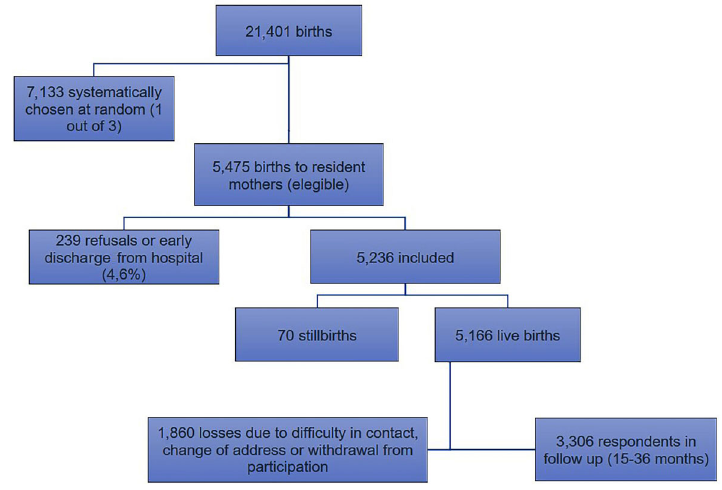
Figure 1. Sample fl owchart of the BRISA birth cohort in São Luis, MA, Brazil, 2010 – 2013.